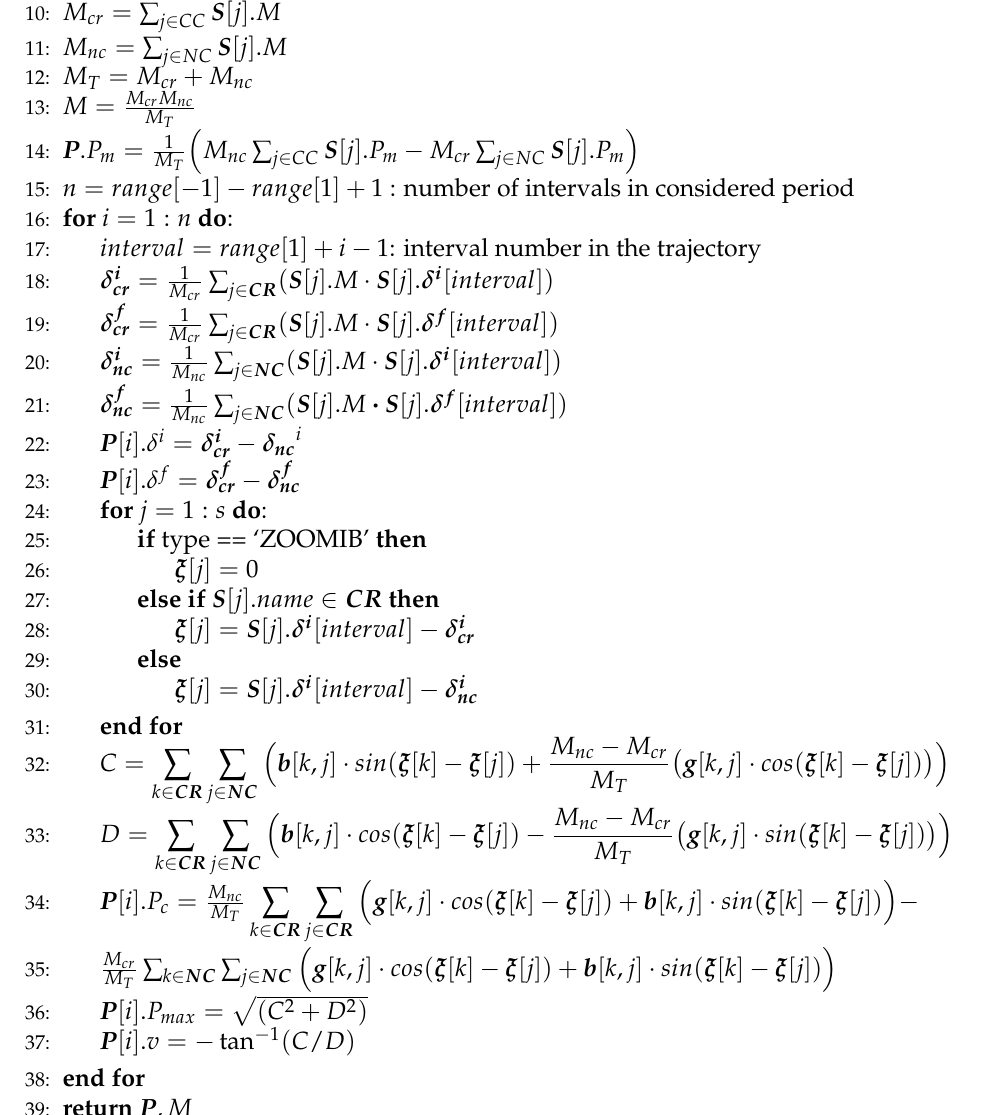
Algorithm A1 Cont.